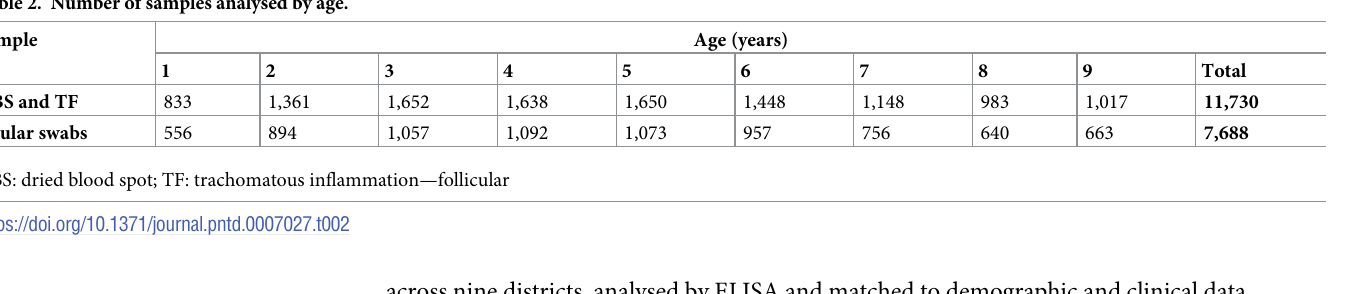
Table 1. A total of 10,902 DBSs were also analysed by MBA. The number of samples taken by age group are detailed in Table 2. A total of 7,688 ocular swabs were taken across six districts, analysed and matched to demo- graphic and clinical data. Overall, 50.2% of individuals surveyed were male and the median age was 5 years old.